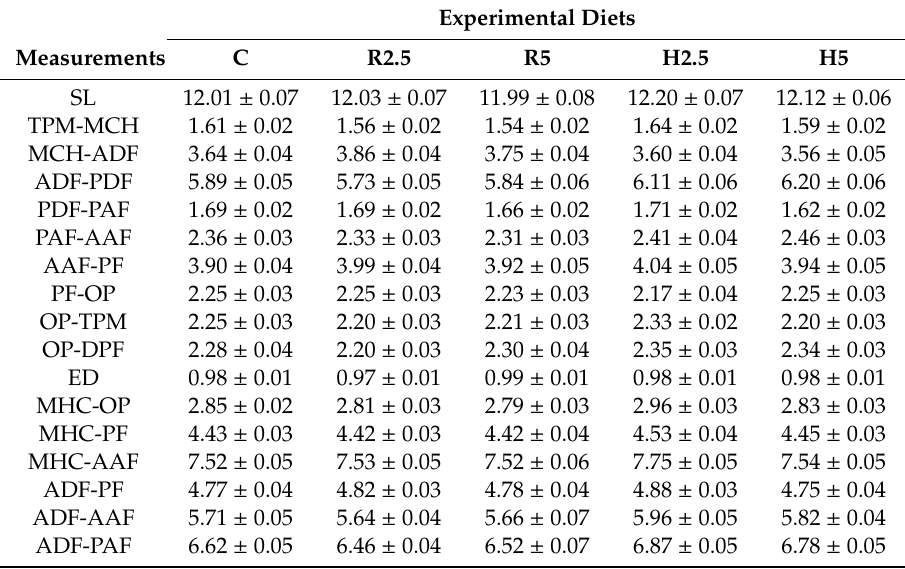
Table 7. Morphological traits of gilthead seabream fed the experimental diets over 90 days.